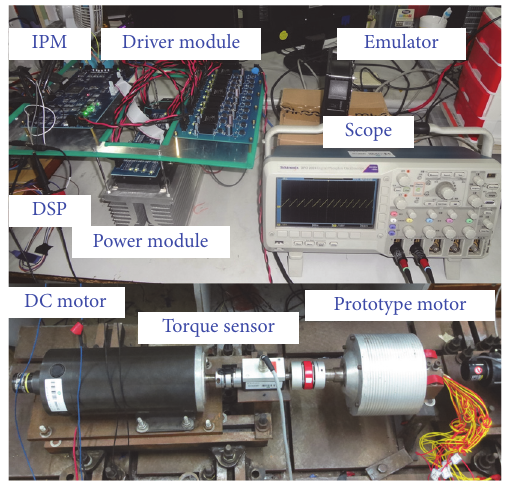
Figure 13: Prototype motor and experimental platform.